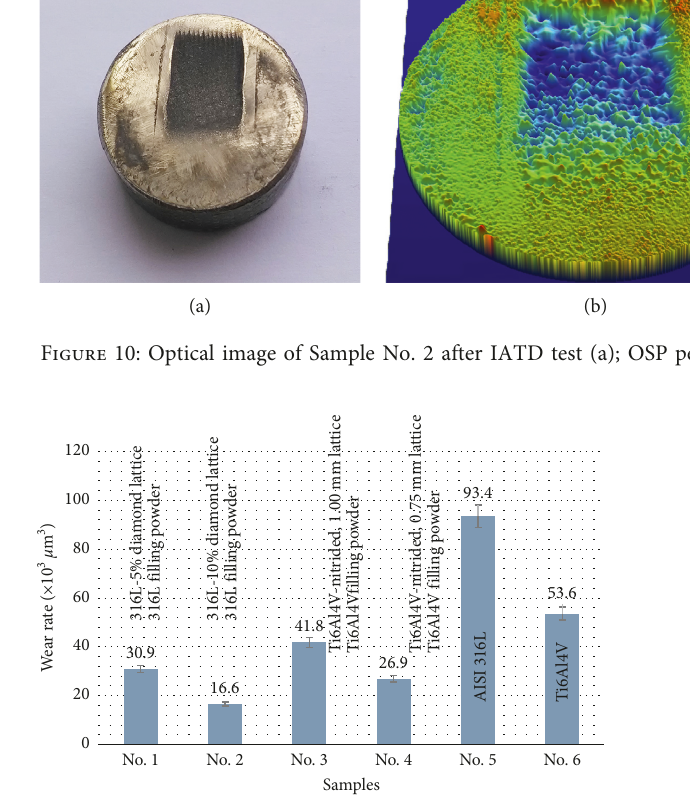
Figure 11: Wear rates of materials during impact-abrasive test.